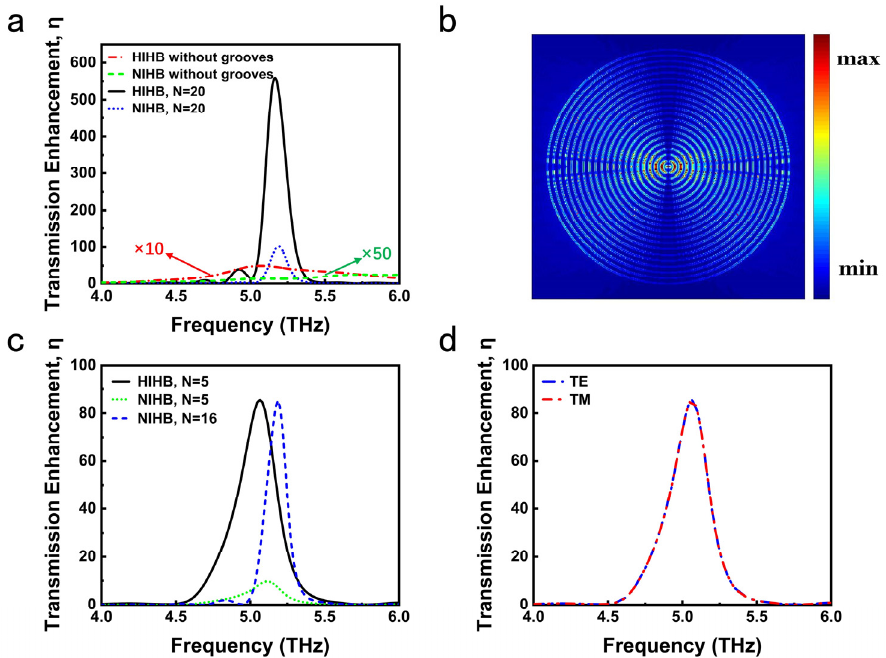
Figure 3. ( a ) The transmission enhancement spectra for 4 cases of structure; ( b ) top view of the electric field distribution of the HIHB structure at N = 20; ( c ) a comparison of the transmission enhancement spectra for these two structures; ( d ) polarization independence of transmission enhancement for TE and TM.